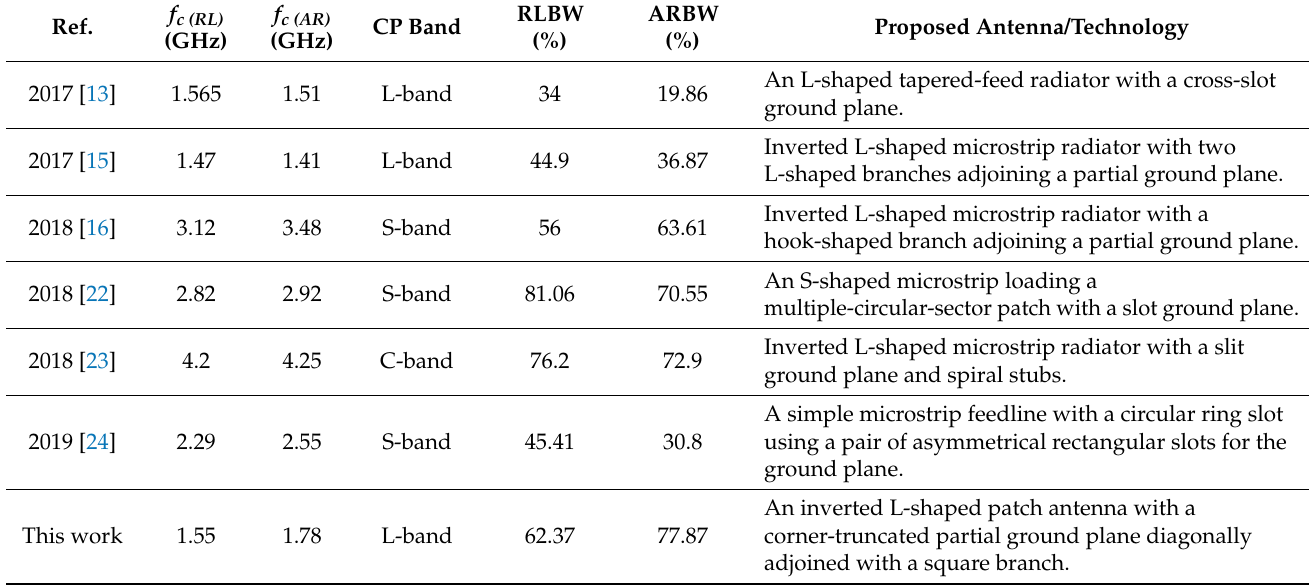
Figure 21. The simulated and measured radiation patterns: ( a ) LHCP, ( b ) right-hand circular polarization (RHCP). Table 4. The antenna parameters, return loss bandwidth (RLBW), and axial ratio bandwidth (ARBW) of existing studies and the current research.